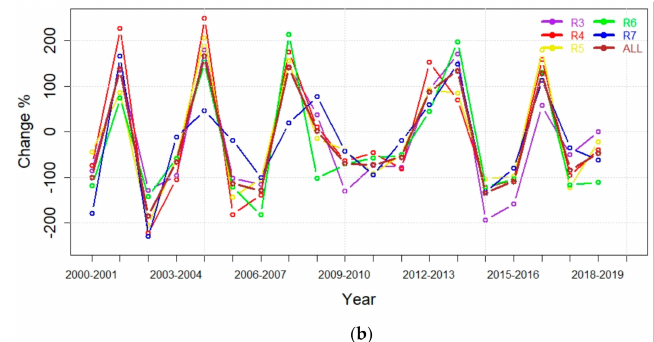
Figure 11. The percent change in PAM ET (mmyr − 1 ) between reaches and from year-to-year on the LCR. The horizontal line, box, and whisker ends indicate the median, 25th and 75th percentiles, and 10th and 90th percentiles, respectively, and data points outside this range are shown by dots ( a ); rate of change in PAM ET is shown with lines for each reach annually during 2000–2019 ( b ).